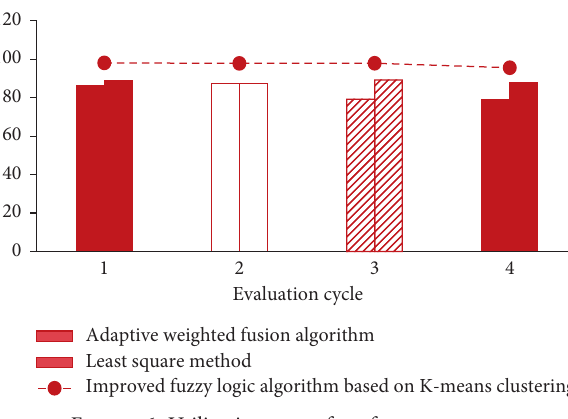
Figure 6: Utilization rate of performance test. Table 3: Results of fusion